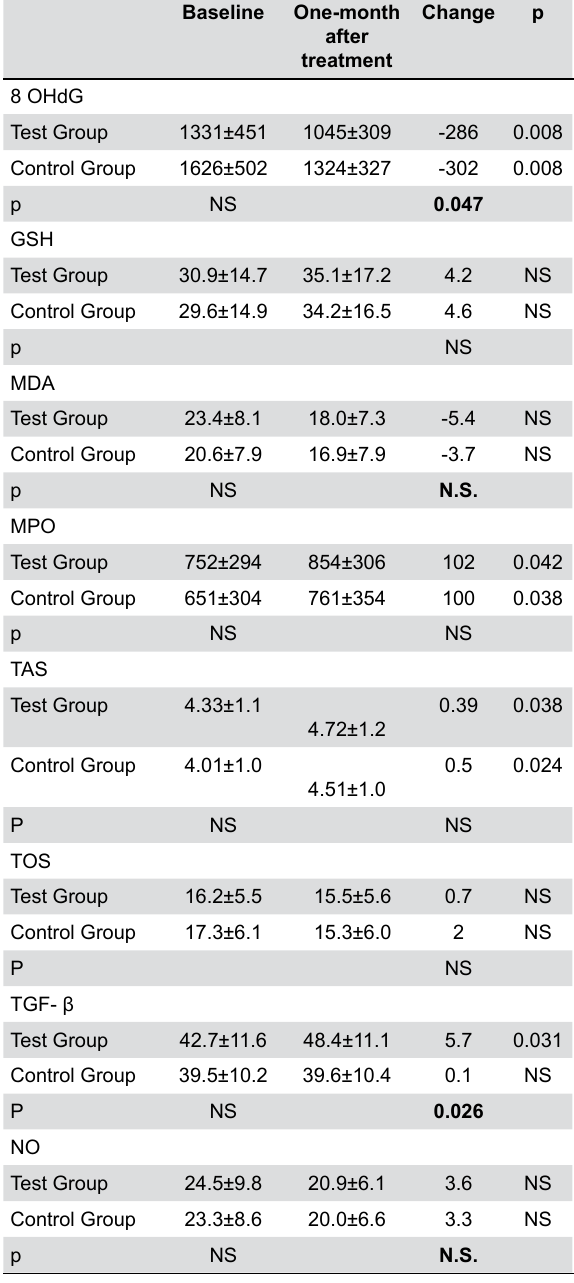
Table 2- The compared inter- and intragroup clinical findings at baseline and one month after treatment (mean±SD)